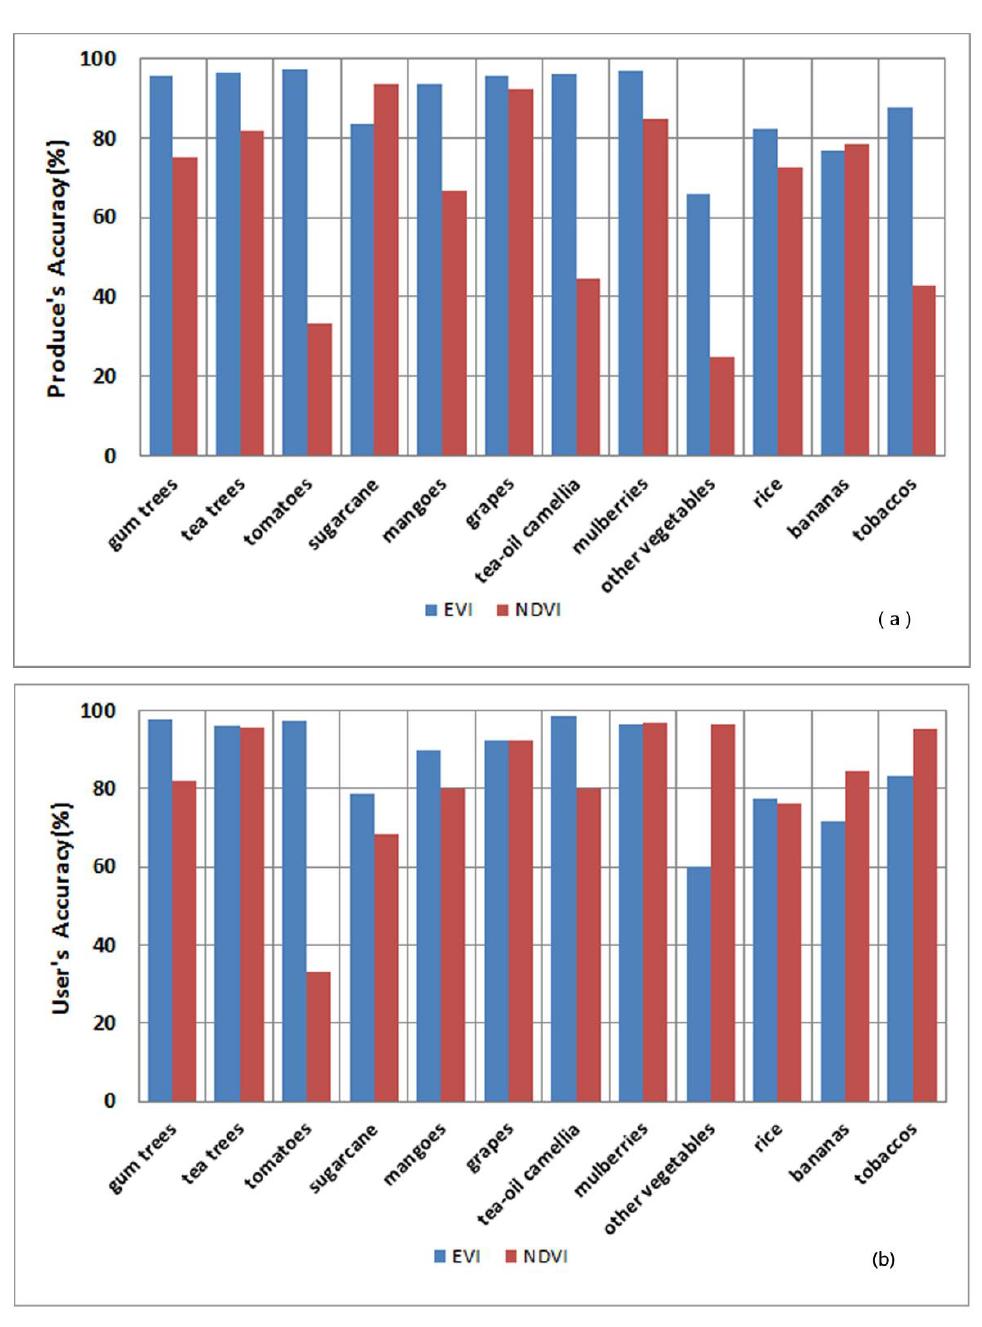
Figure 4. ( a ) Producer’s and ( b ) user’s accuracies for individual crop types.